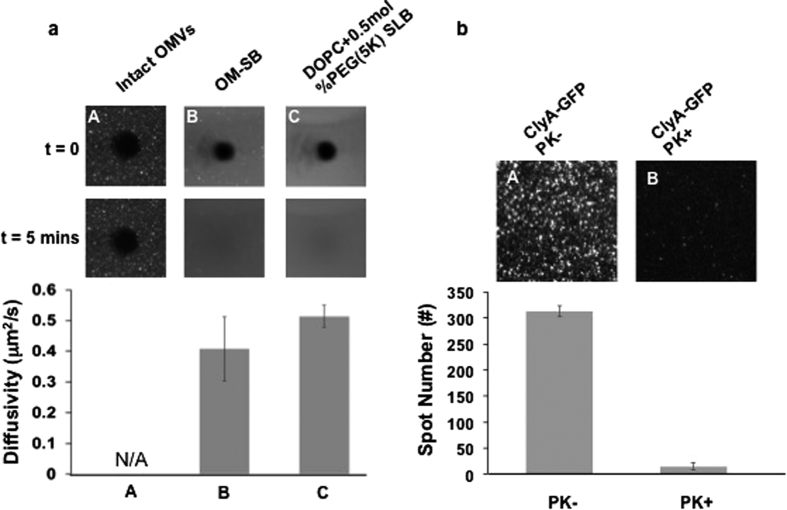
(a) Microscopic images of fluorescence recovery after photobleaching. (A) Intact OMVs labeled with R18. (B) OM-SBs labeled with R18. (C) DOPC with 0.5 mol% PEG(5K)-PE SLBs labeled with R18. The bar graph summarizes the diffusivities of these three types of supported bilayers. Note that due to the immobility of Sample A, no diffusivity could be determined. (b) Microscopic images of OM-SB expressing ClyA-GFP before (A) and after (B) Proteinase K treatment. The intensity of the punctate spots was abolished dramatically after the addition of proteinase K, which indicates that the majority of ClyA-GFP face up toward the bulk solution and that the orientation of the SB is the same as the OMV and bacterial cell. The bar graph below summarizes the densities of bright spots in the images. Multiple runs (n > 3) were performed to obtain bilayer diffusivities and particle numbers.